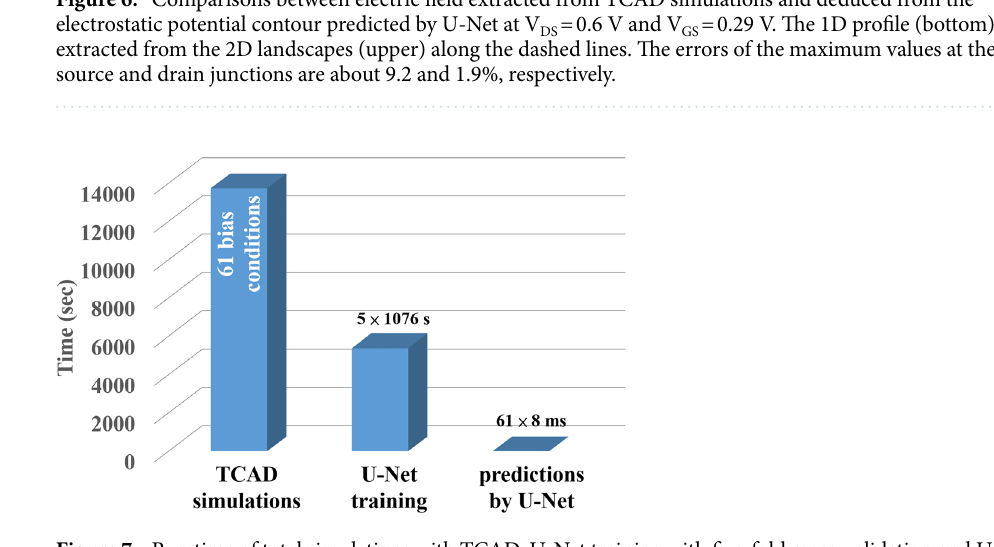
Figure 7. Run time of total simulations with TCAD, U-Net training with five-fold cross-validation and U-Net prediction for 61 sets of physical quantities (electrostatic potential and electron density